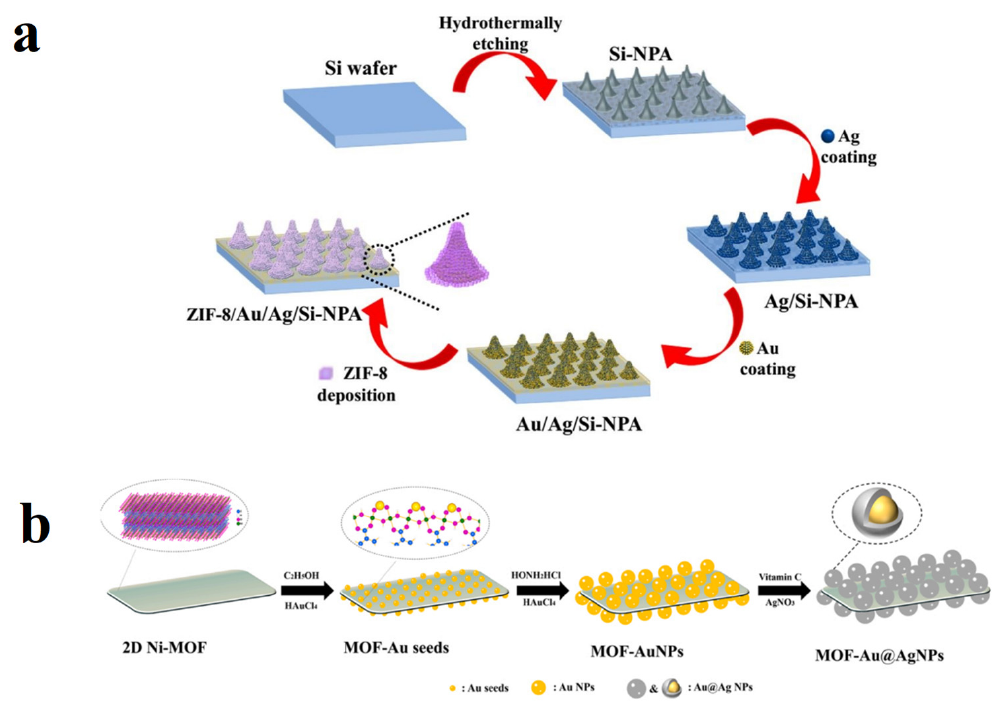
Figure 5. ( a ) Schematic diagram of preparation of ZIF-8/Au-Ag/Si-NPA active substrate [89]. ( b ) 2D Ni-MOF-Au@AgNPS Preparation of composite materials [55].